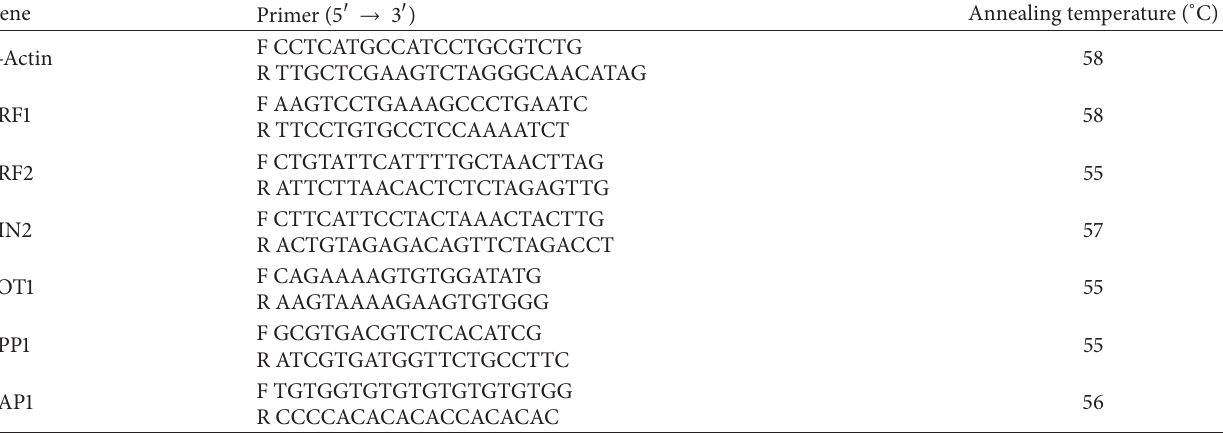
Table 1: Target gene primer sequences and annealing temperature.